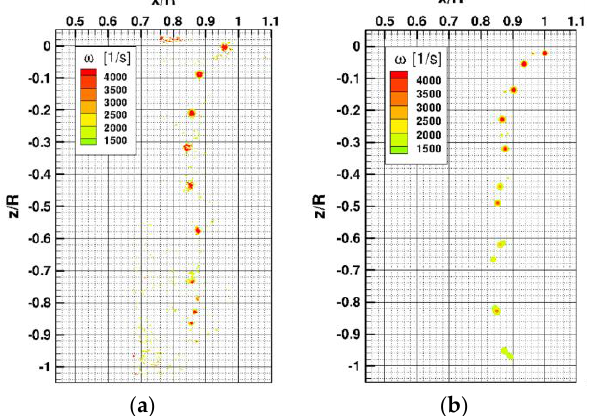
Figure 14. Experimental ( a ) and numerical ( b ) vorticity = (∇ × V) ⊥ in the PIV plane. The numerical simulations allowed the visualization of the entire wake structure gen- erated by the rotor. In particular, it was possible to visualize the tip vortices and to asso- ciate them with the generating blades. Figure 15a shows the numerical tip vortex structure up to a distance of z = −1.5 R below the rotor disk. Each of the four colours corresponds to a vortex filament generated by the relative blade. The image illustrates that the vortex structure keeps a geometrical regularity until a distance between z/R = −0.5 and −0.6, after which the wake starts showing more chaotic behaviour. A second aspect that is high- lighted in the figure is the pairing phenomenon according to which the mutual positions of the vortex filaments tend to interchange after a first rotor revolution. More specifically, looking at the sequence of the tip vortices at about x/R = + 1.0, it is: cyan-blue-green-red during the first revolution but becomes cyan-green-blue-red during the second revolu- tion. This means that the vortices blue and green begin to roll up with each other until